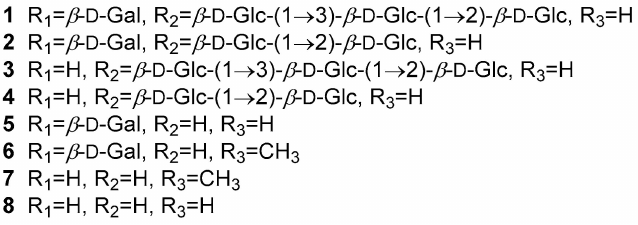
Figure 1. Chemical structures of compounds 1 –